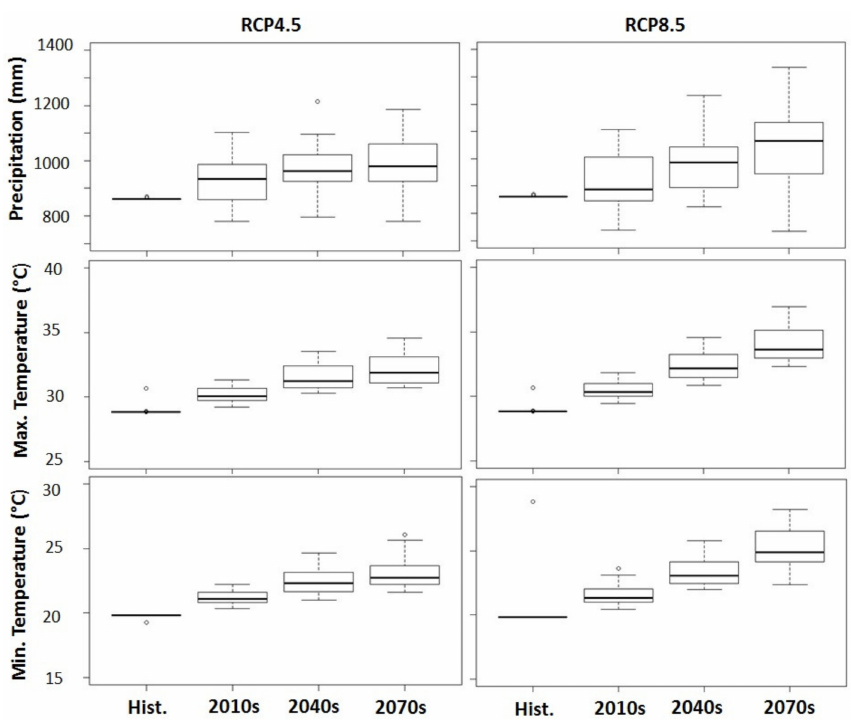
Figure 6. Percentage (%) change of total precipitation, mean maximum temperature and minimum temperature during the cropping period (June-September) in Jeonju metrological station for the 2010s (2nd column), 2040s (3rd column), 2070s (4rd column) considering RCP4.5 ( left side ) and (2) RCP 8.5 ( right side ) scenarios relative to the historical period (1st column) considered as baseline (1976–2005). Table 6. The multimodal ensemble (MME) means of historical agroclimatic and water balance parameters, and climate change period and percent change in comparison to the historical period in